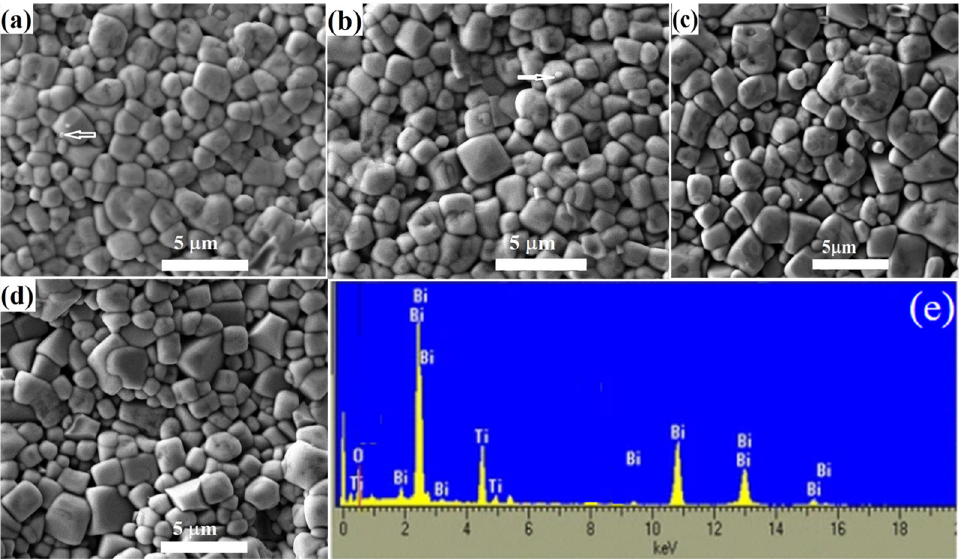
Figure 2. Scanning electron micrographs of ( NBT-BT-NBN 1 − x T x ) ceramic compositions: ( a ) x = 0.00; ( b ) x = 0.05; ( c ) x = 0.10; ( d ) x = 0.15. ( e ) EDS spectrum of the bismuth pyrochlore Bi 2 Ti 2 O 7 that developed as a secondary phase, indicated by arrows in the microstructures.